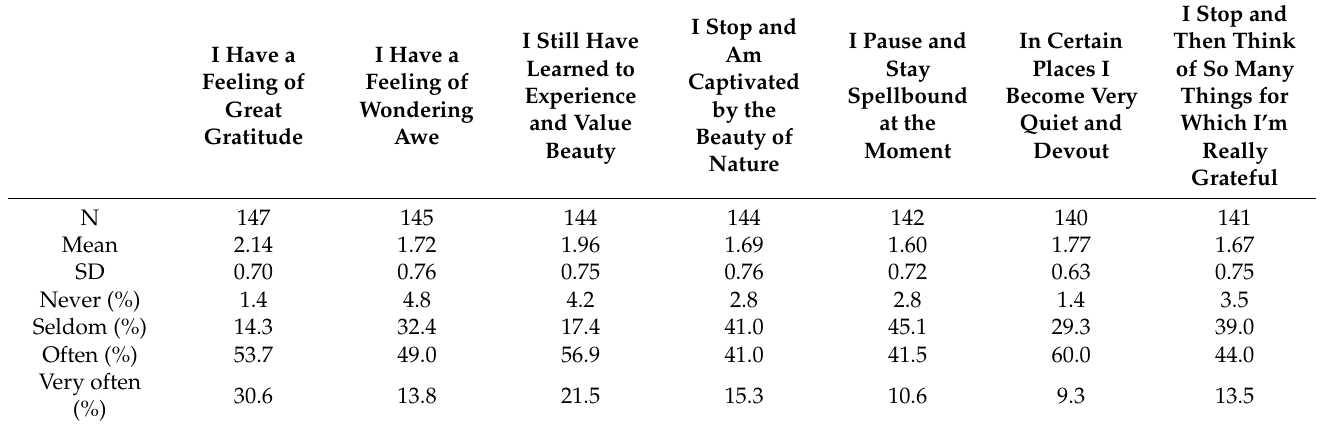
Table 2. a . Intensity of Awe/Gratitude perceptions in the sample.